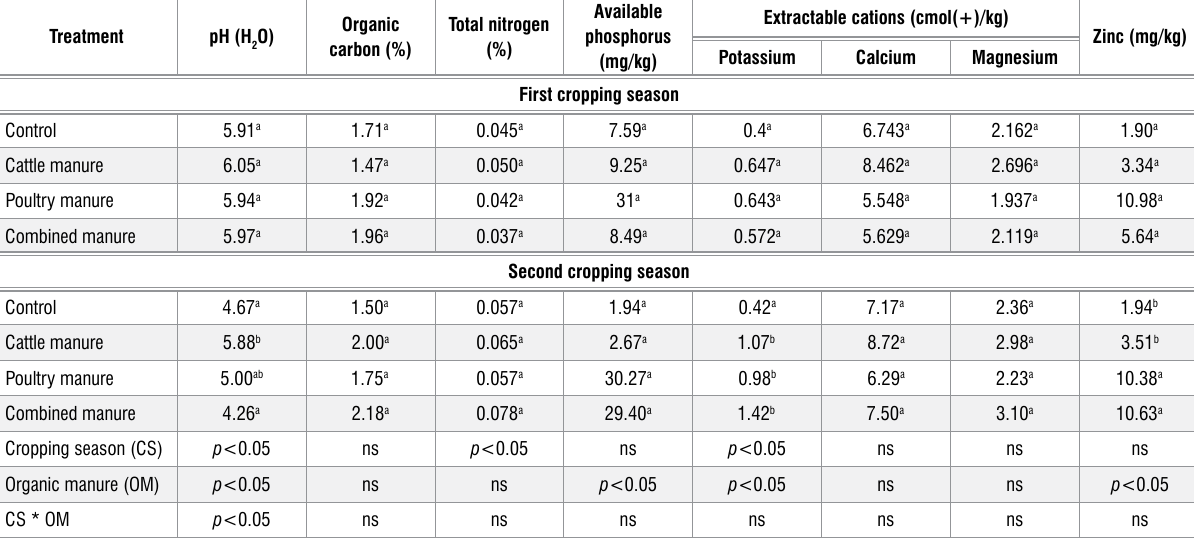
Table 5: Effect of organic manure on surface soil chemical properties for 2013/2014 and 2014/2015 cropping seasons